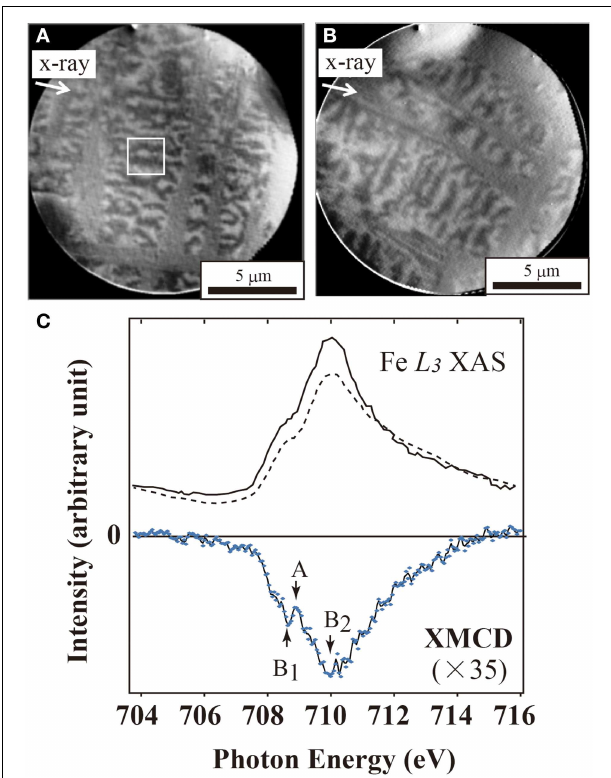
FIGURE 3 | Magnetic domain structure of the same area of the magnetite specimen in Figure 2. (A) XMCD images obtained using the difference between two different helicities acquired from the Fe L 3 absorption edge (708.4 eV). The host magnetite is cut by a biaxial array of hematite lamellae, and has striped magnetic domains measuring less than about 4 × 0 .8 µ m. The white box indicates the acquisition area for XAS and XMCD. (B) Rotation of the image in (A) by 70 ◦ about an axis vertical to the specimen. No change was observed in the domain structure, suggesting that the magnetic moment was directed toward the out-of-plane component. (C) XAS and XMCD spectra of the X-ray Fe L 3 edge of the magnetite matrix. The solid and dashed lines are the XAS spectra of two different helicities, and the blue dots indicate the XMCD spectrum, which shows a positive peak (A) and two negative peaks (B 1 and B 2